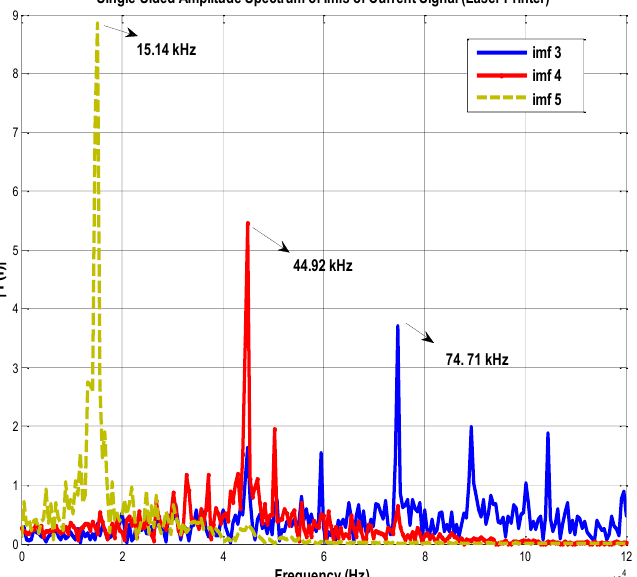
Fig 6. Frequency IMFs components for current of Laser Printer